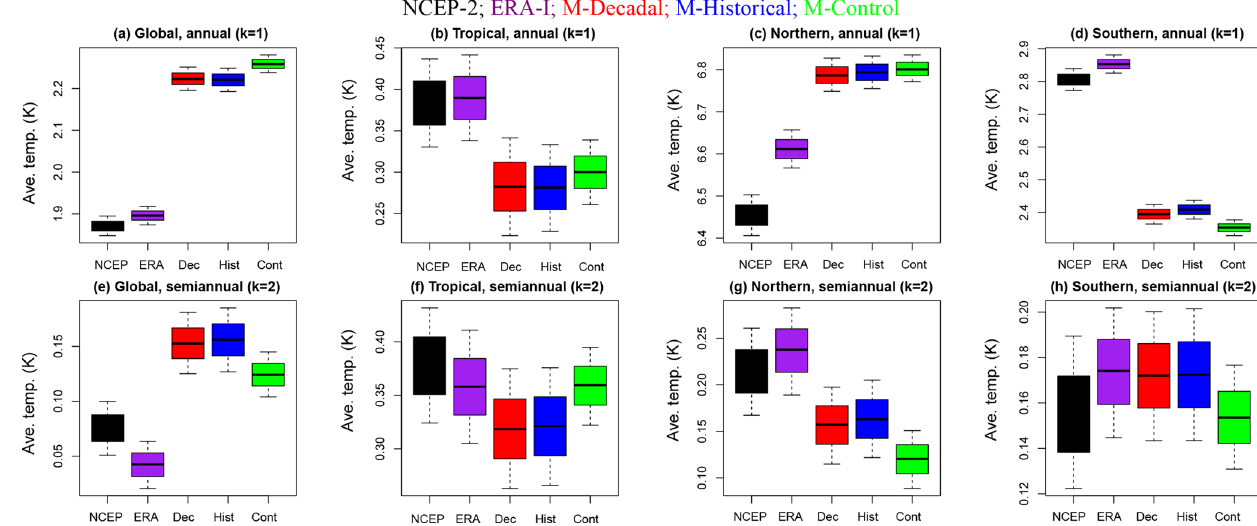
Figure 3. Posterior amplitude samples for harmonics k = 1, 2. Varying model versus reanalysis differences are seen across domains; however, we do not find any cases in which there are significant amplitude differences between the three types of model simulation. Whiskers indicate the maximum and minimum values and boxes indicate the 95% posterior intervals. Different colors denote the type of simulation and the reanalysis